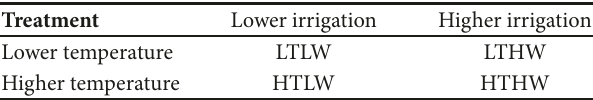
Table 1: Treatment codes representing the combination of temper- ature and irrigation levels that were used in the experimental